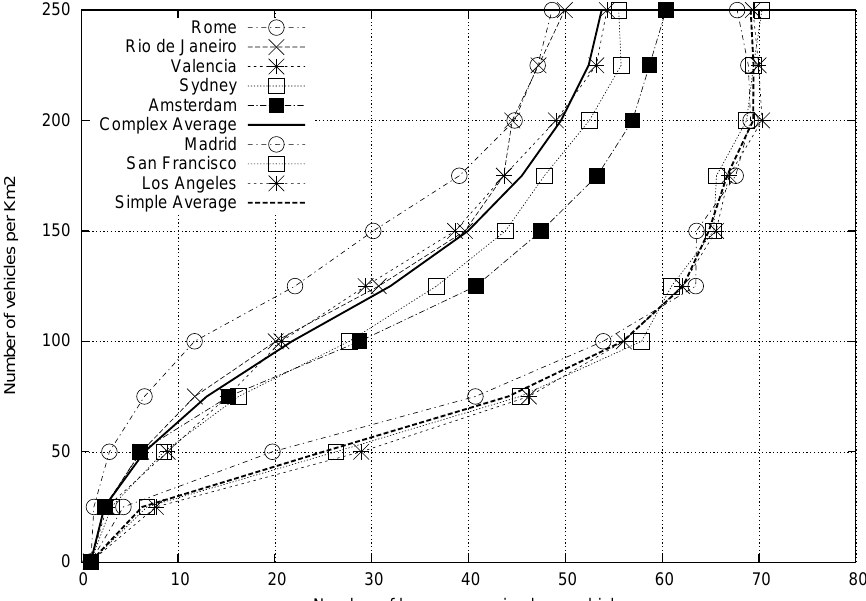
Figure 2. Number of beacons received when varying the vehicular